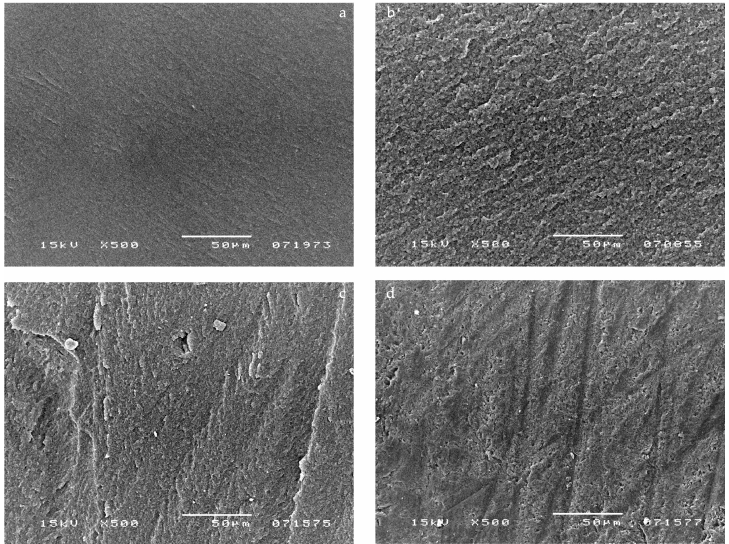
Figure 2. SEM photomicrographs illustrating fractured surfaces for samples bonded with Clearfil S 3 Bond. SEM analysis showed a reduced number of small droplets within the adhesive layer of this DBA applied without pulpal pressure (0 cm H 2 O) ( a ). ( b ) Micrograph shows a representative sample of Clearfil S 3 Bond applied simultaneously to pulpal pressure (20 cm H 2 O). In contrast to the 0 cm pulpal pressure group, almost the entire adhesive layer was affected by droplets. ( c , d ) Micrographs show the morphology of the adhesive applied and cured after the application of pulpal pressure (20 cm H 2 O). A reduced number of droplets was displayed. The Clearfil Protect Bond SEM micrographs show the absence of droplets within the adhesive layer of this DBA applied without pulpal pressure (0 cm H 2 O) (Figure 3a,b). The micrographs in Figure 3c,d showed a representative sample where pulpal pressure was inserted after Clearfil Protect Bond application and curing. A high density of resin tags and no droplets were displayed.